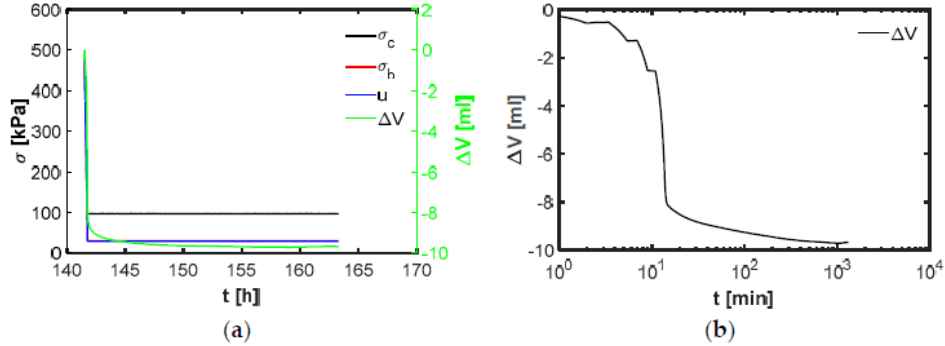
Figure 8. Consolidation phase time plots for soil oM: ( a ) pressures and volume change vs. time; ( b ) volume change vs.